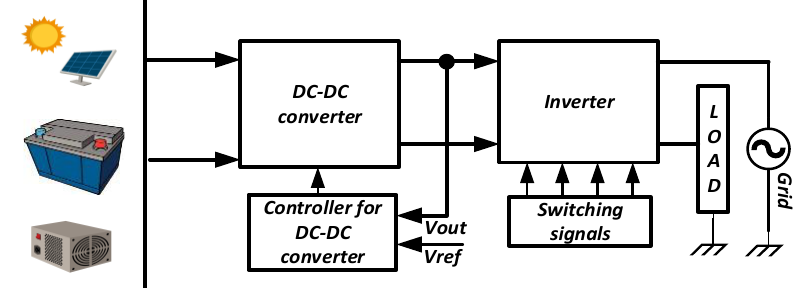
Figure 1. General configuration of the PV-based inverters for AC loads or grid applications.